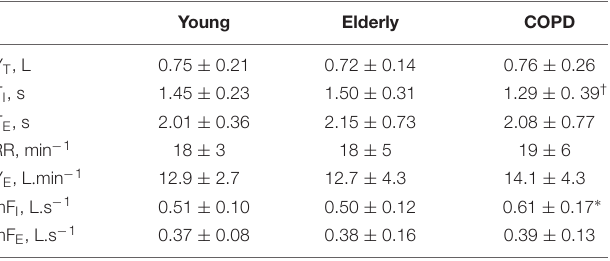
TABLE 2 | Breathing pattern parameters in healthy and COPD subjects.